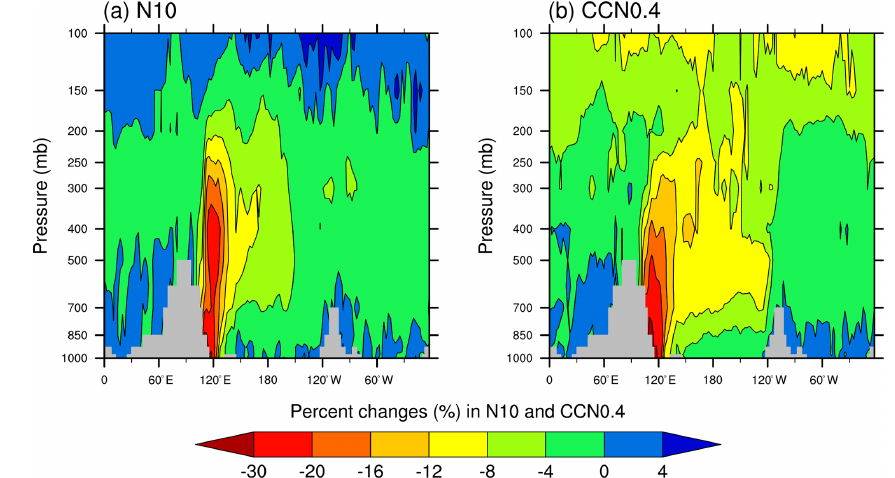
Figure 3. Pressure–longitude distributions of the percent differences of the N 10 and CCN0.4 along latitude 35 ◦ N between the Exp08 and Exp16 simulations. N 10 : particle number concentrations with the diameters larger than 10nm; CCN0.4: diagnostic CCN number concentra- tions at supersaturation of 0.4%.